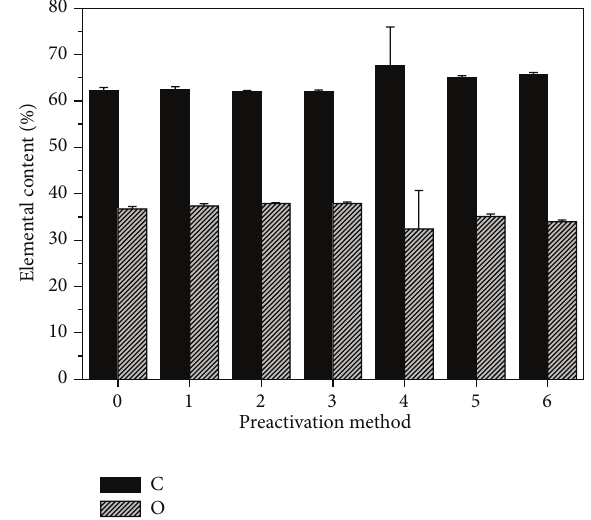
Figure 3: XPS investigations of untreated and plasma preactivated PLA fiber